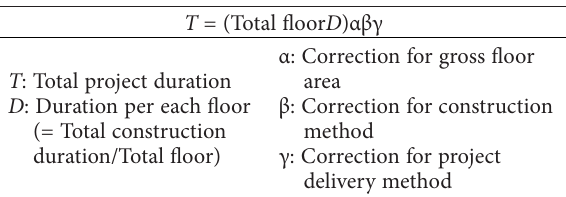
Table 1. Construction duration computation model by contractors during the project planning